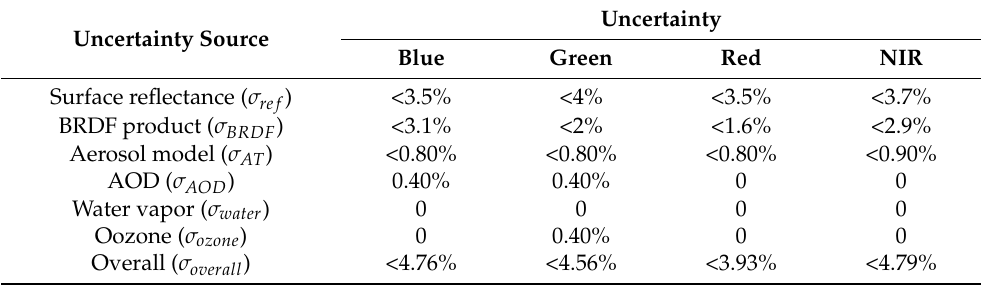
Table 2. The determined uncertainties in the calibration of FY-3D MERSI-II brought by each involved factor and the total uncertainties of all the factors for the four spectral bands. Uncertainty